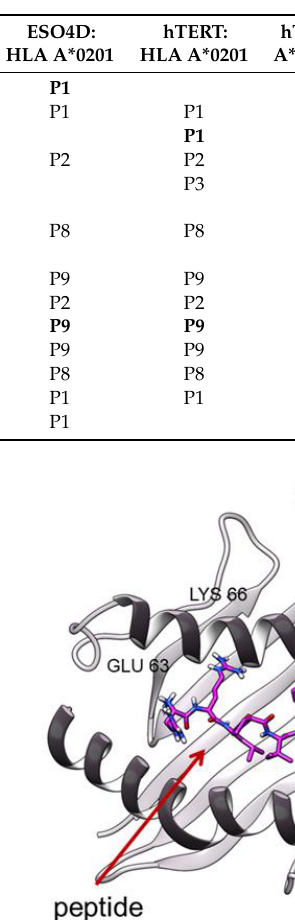
Table 2. Hydrogen bonds between the peptide and the binding groove. The a.a. residues involved in the interaction are listed on the left. The residue of the peptide which makes the h-bonds is labelled with “P”, and the associate number denotes its position in the peptide sequence.